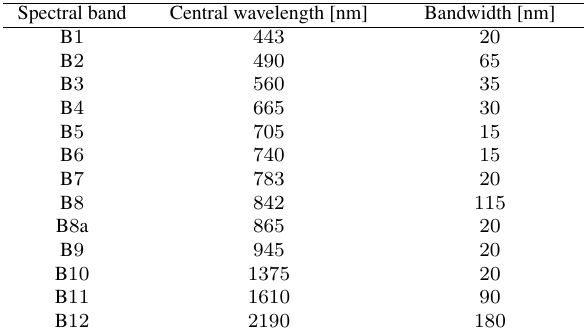
Table 1. Definition of the spectral bands given for Sentinel-2